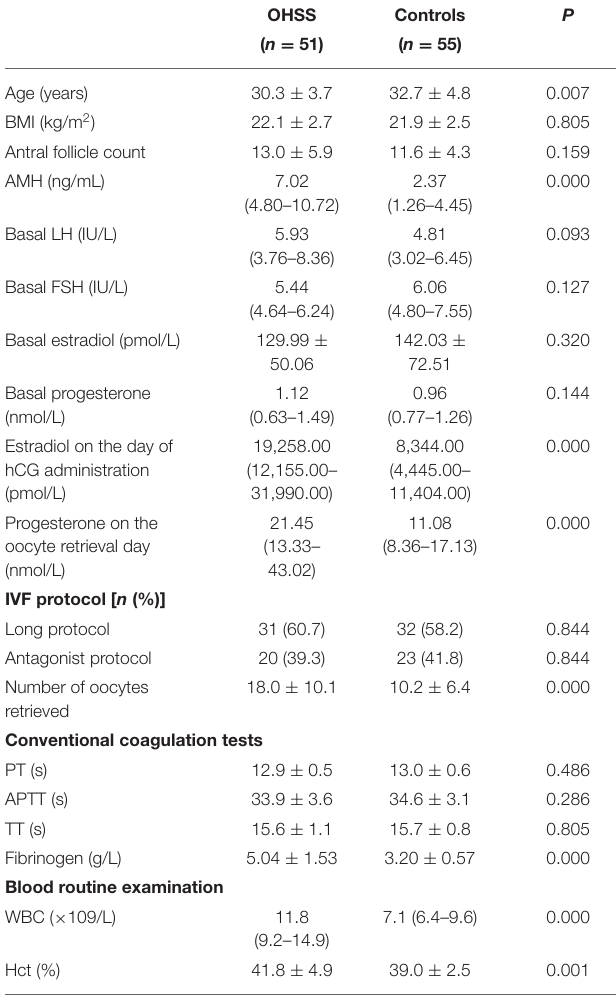
TABLE 1 | Baseline clinical characteristics of the